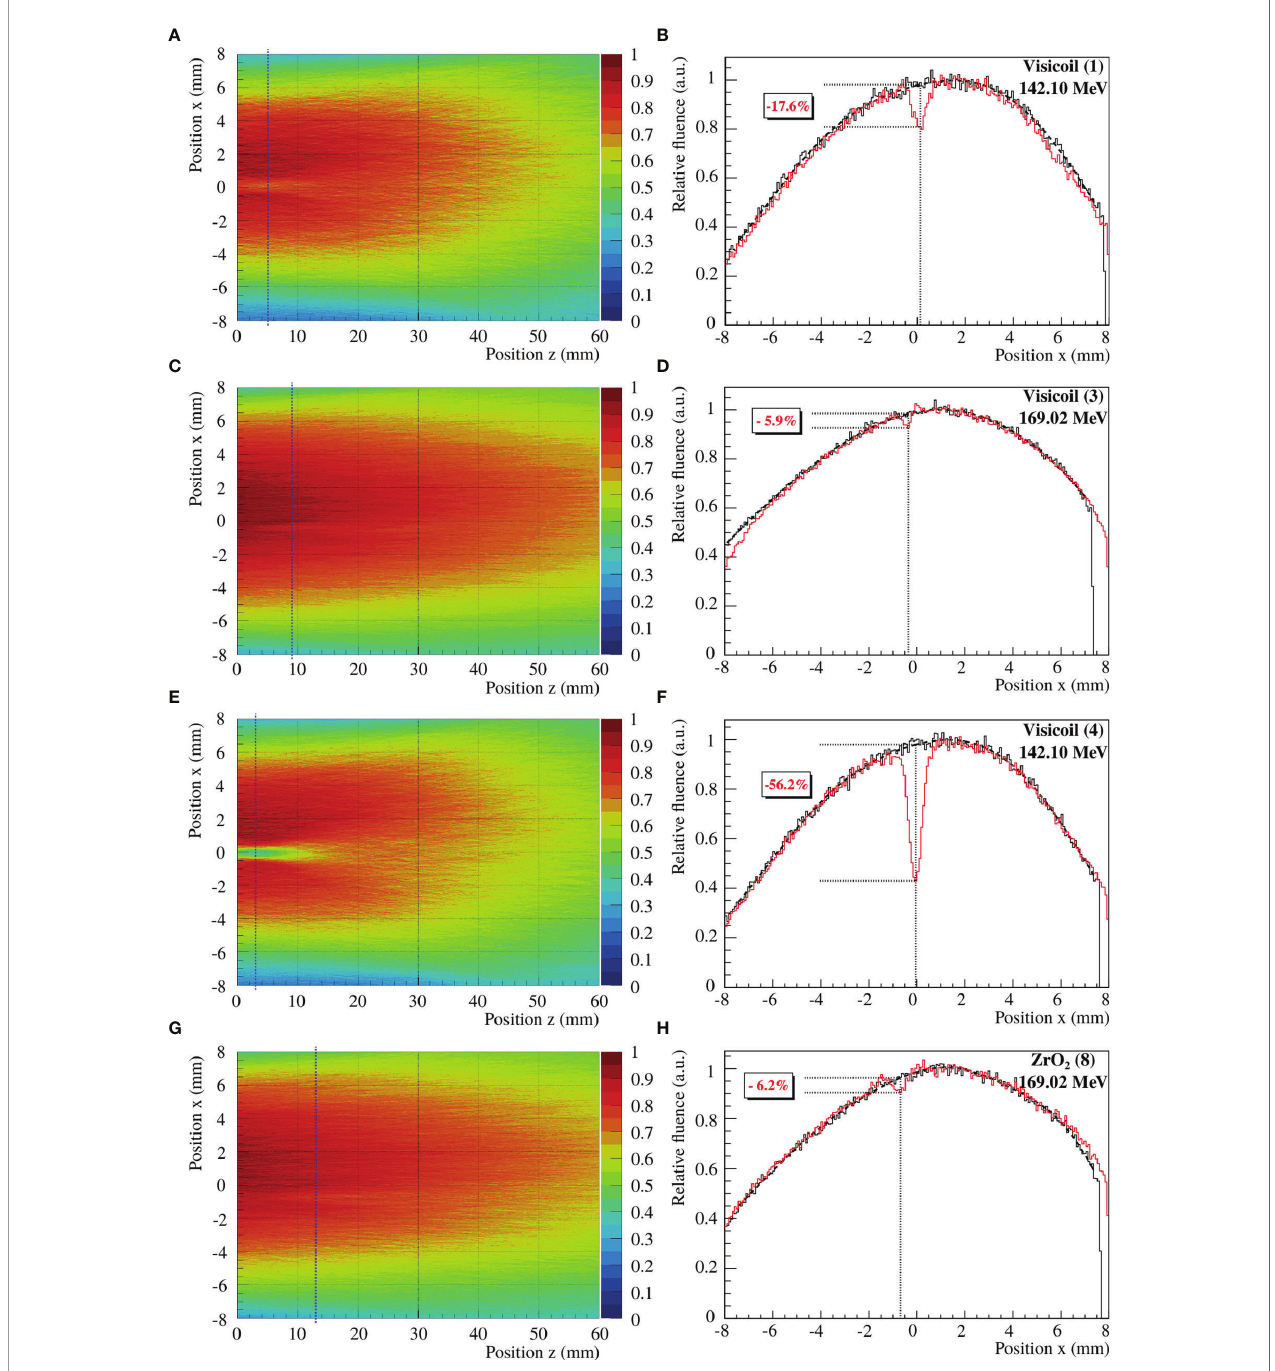
FIGURE 8 | Measured fl uence maps and beam pro fi les of 142.10 and 169.02MeV proton beams through Visicoil (1), Visicoil (3), Visicoil (4), and ZrO 2 (8), placed at position zero along the z -axis and x -axis. (A, C, E, G) show the fl uence maps reconstructed from all tracks. (B, D, F, H) show their corresponding pro fi le at the z position where the perturbation is the strongest. The black vertical dash-dotted line on the fl uence map represents the corresponding position along the beam axis where the fl uence perturbation is maximum. In (B, D, F, H) , the red line shows the pro fi le at this position with the marker, while the black line shows the pro fi le without marker for the same z position. In the same panels, the vertical dotted line indicates the position in x of the maximum perturbation while the dotted horizontal lines quantify the strength of the